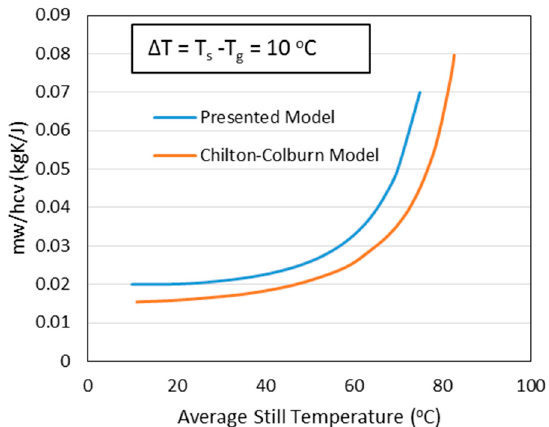
Figure 6. me/hcv Corresponding to Chilton-Colburn Model.